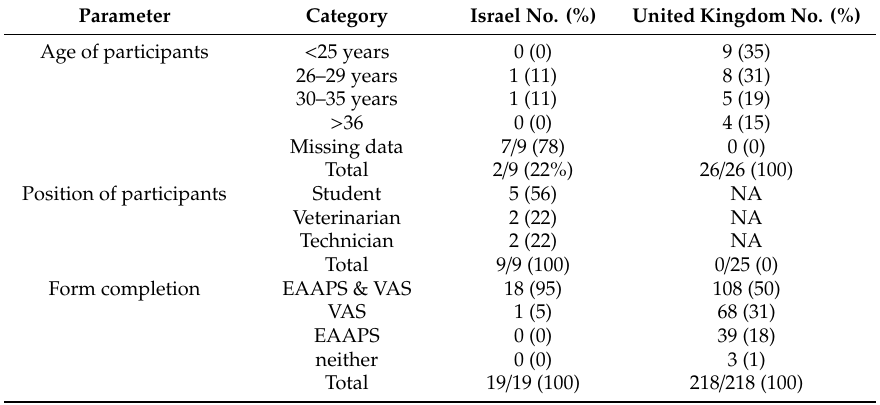
Table 2. Characteristics (age and position) of participants ( n = 35) who scored the pain severity of horses presenting with colic by location and information from the completed forms ( n = 237) regarding the use of the two scales; Equine Acute Abdominal Pain Scale (EAAPS) and the visual analogue scale